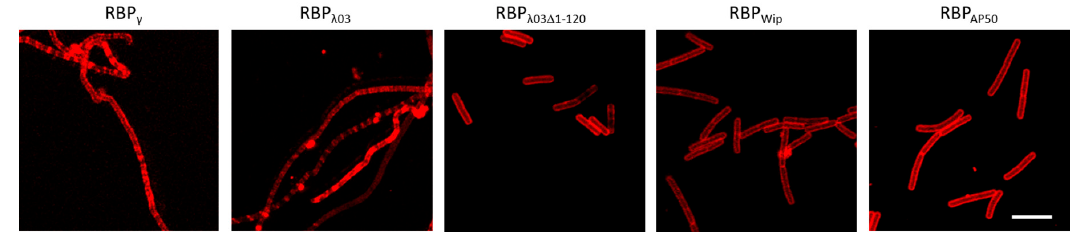
Figure 2. Representative fluorescent microscopy detection of B. anthracis cells using RBP reporters. Cultures of B. anthracis CDC 1014 were grown for 2–3 h, washed with HEPES-Ringer-bu ff er, mixed with RBP, washed again to remove unbound RBP and subjected to fluorescence microscopy. Shown are mCherry-RBP reporters of phage Gamma (RBP γ ), prophage LambdaBa03 (RBP λ 03 ∆ and truncated RBP λ 03 ∆ 1-120 ), phage Wip1 (RBP Wip ) and phage AP50 (RBP AP50 ). Scale bar: 10 µ